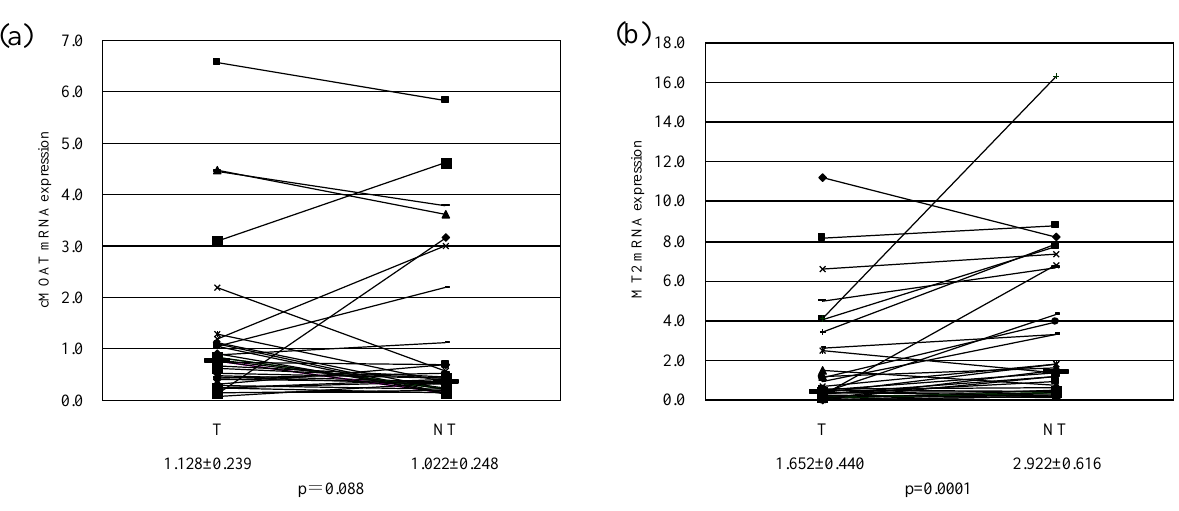
Figure 1. (a) cMOAT mRNA expression in T and corresponding NT (N = 35). (b) MT2 mRNA expression in T and corresponding NT (N = 35). Values are mean ± SE. Bar: median value.